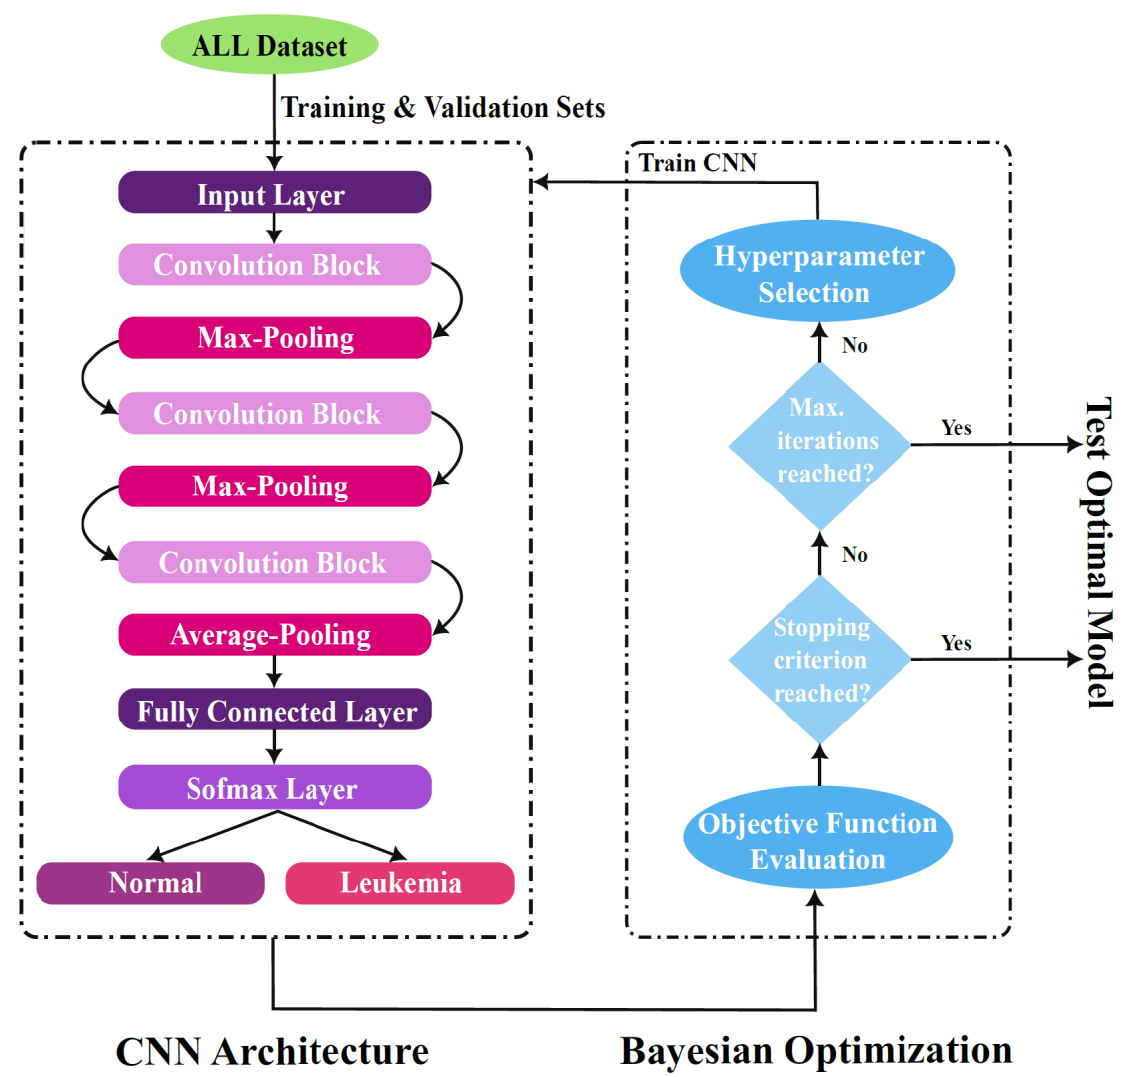
Figure 4. Proposed CNN architecture and Bayesian Optimization for Hyperparameter tuning.